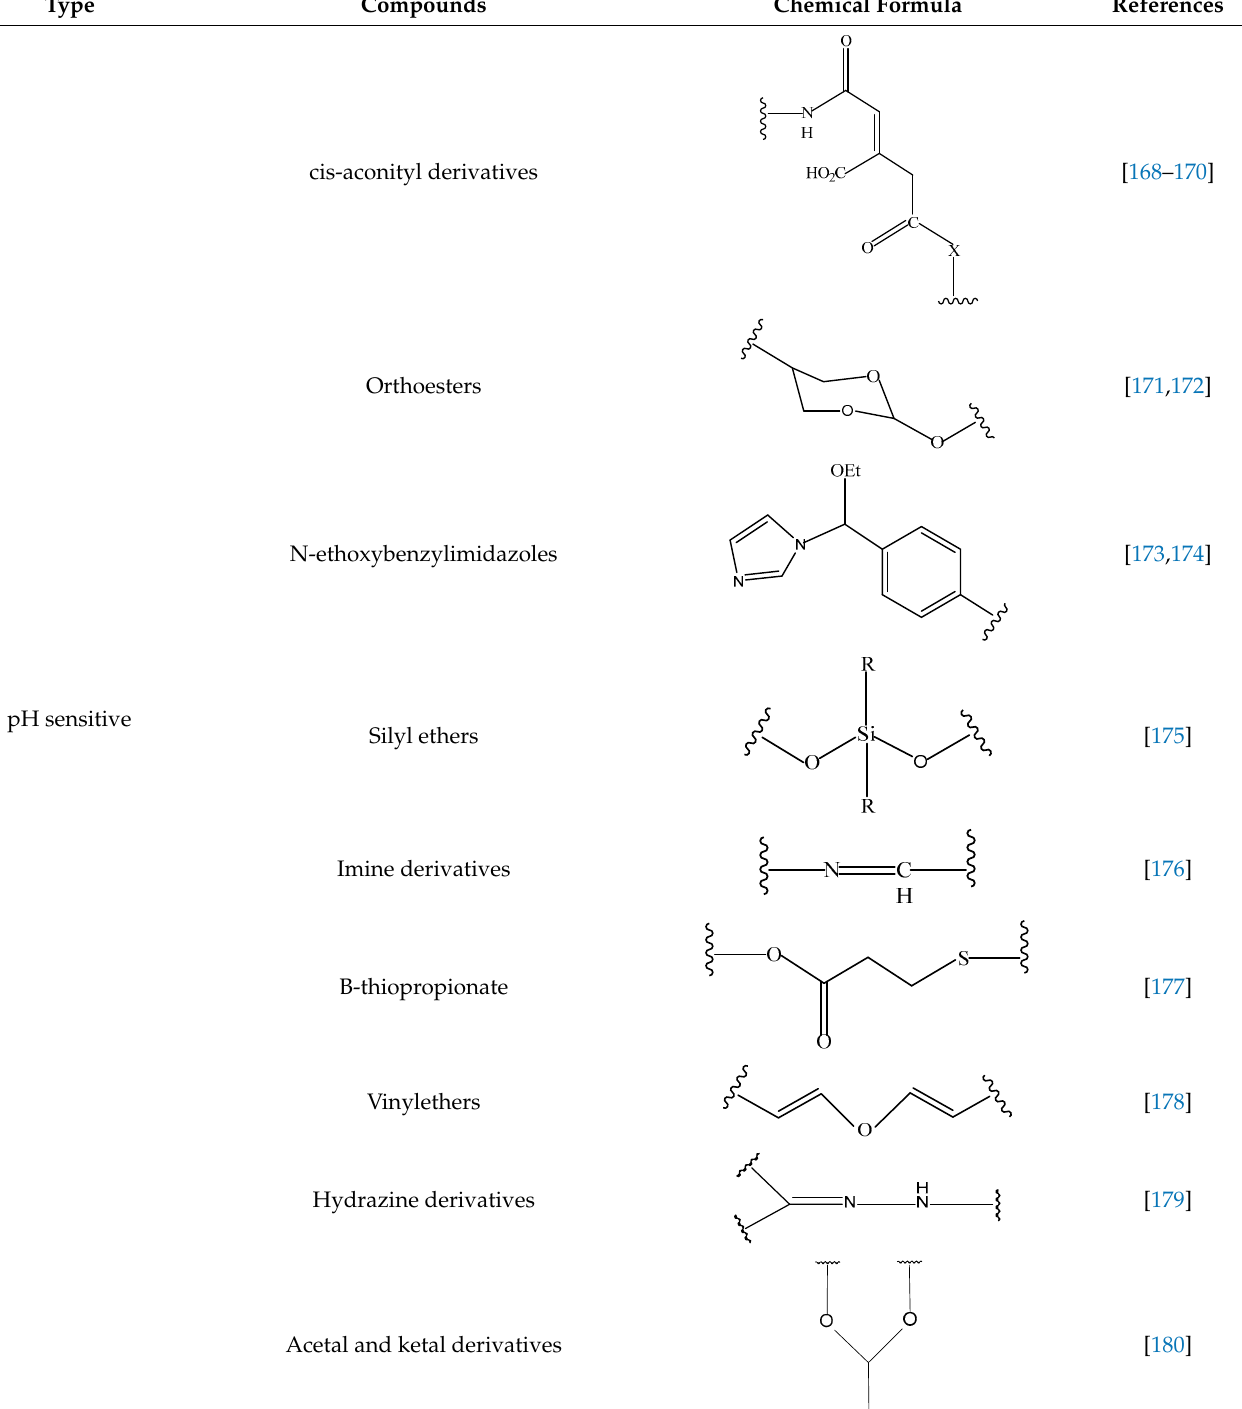
Table 4. Different types of condition-sensitive linkers, which are mainly used in nano-drug delivery systems.